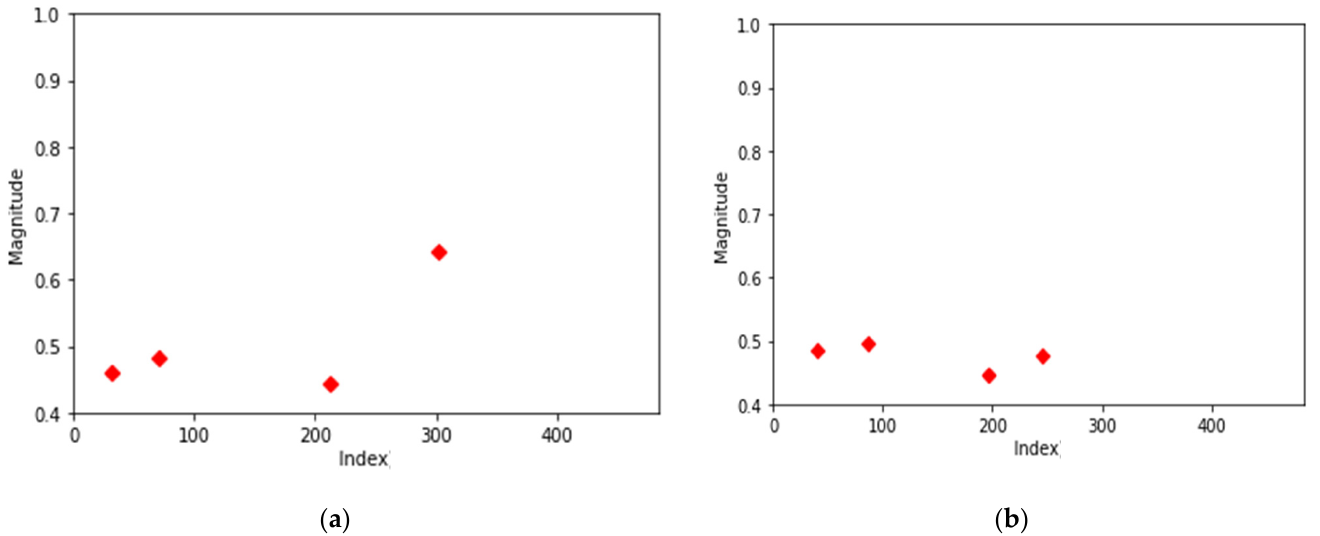
Figure 7. Center points of two most common second-order error data. ( a ) Center points of second- order error data (most common data); ( b ) center points of second-order error data (second common data).